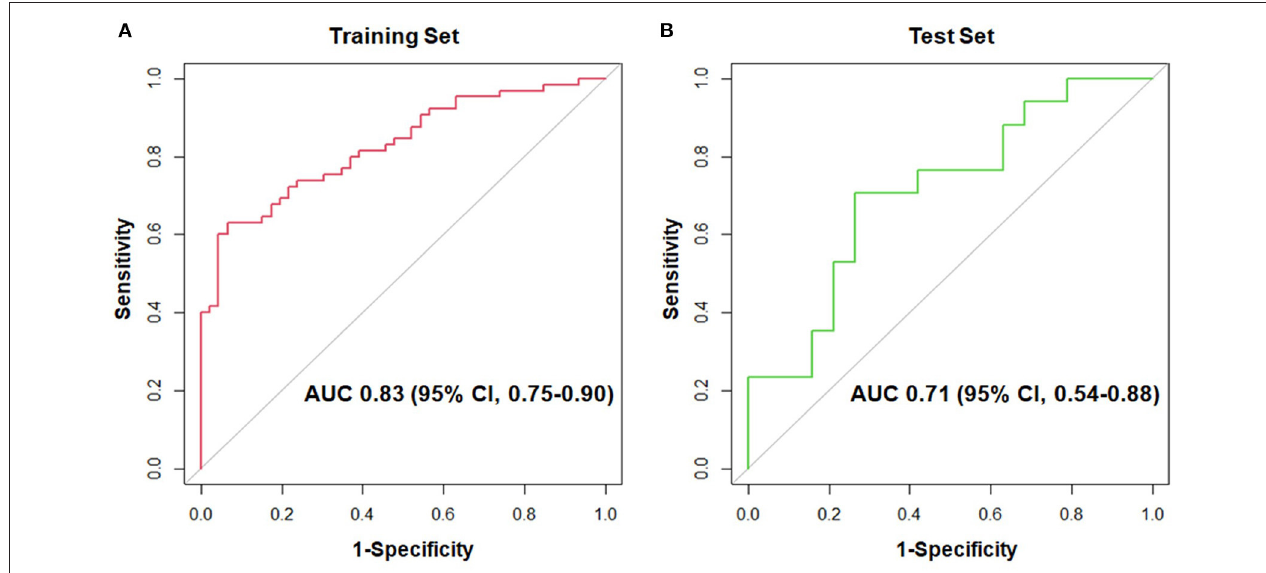
FIGURE 2 | Receiver-operating-characteristic curves for the 17-protein model to distinguish patients with and without late gadolinium enhancement in the hypertrophic cardiomyopathy population. (A) shows the receiver-operating-characteristic curve in the training set, whereas (B) displays that in the test set. AUC, area under the receiver-operating-characteristic curve; CI, confidence interval.